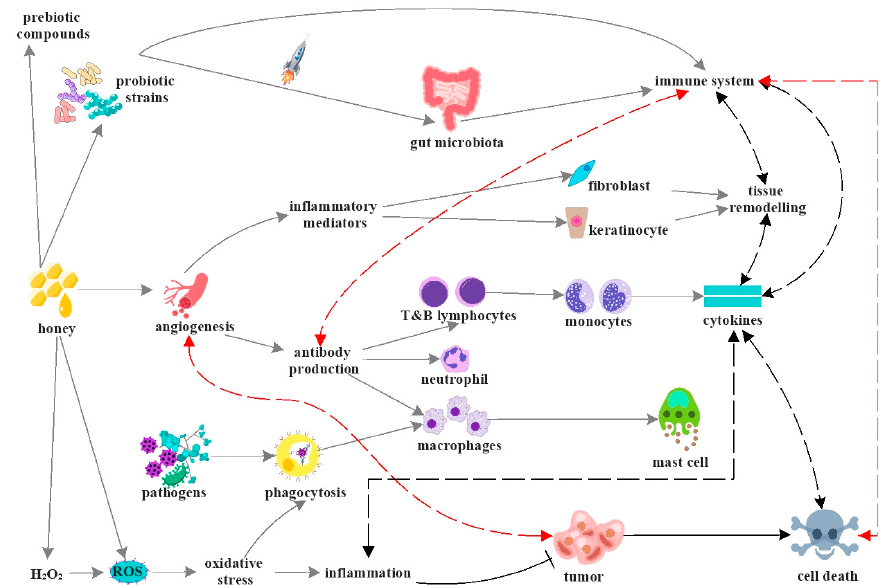
Figure 3. Graphic representation of the immunomodulatory mechanism of honey. The figure was designed with ConceptDraw Diagram 16.